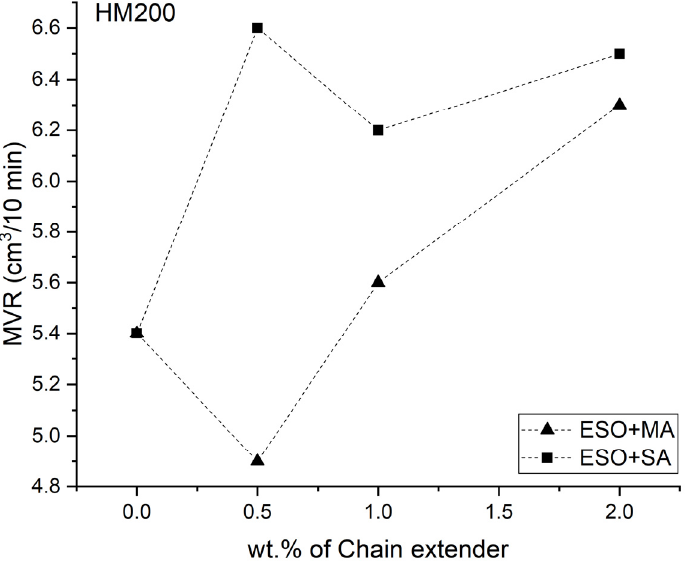
Figure 8. MVR trend for biocomposites based on HM200 HSP.